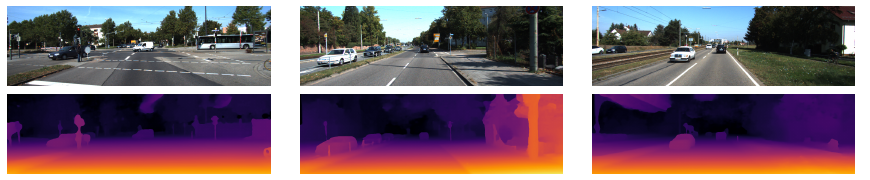
Figure 16. The qualitative results from [34] show the left RGB images from 3 scenes in the KITTI-2015 stereo dataset in the top row and the corresponding disparity map predictions in the bottom row are shown using colour to represent the disparity values. The raw dataset was used for the LiDAR data mapped onto the scenes in the stereo dataset and then the results were converted from depth values to disparity using the calibration